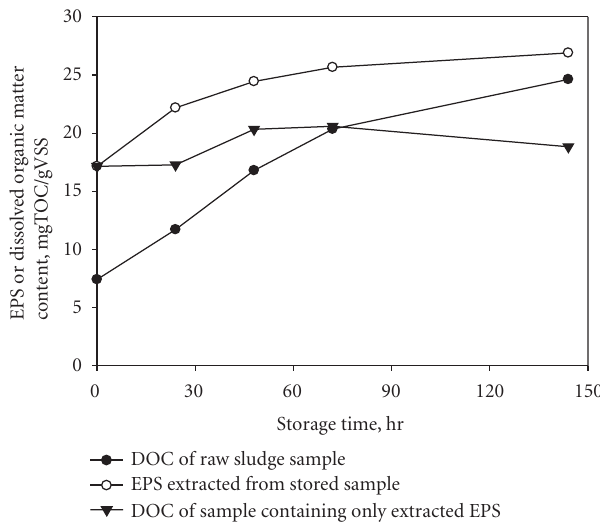
Figure 4: Storage e ff ect on the extraction process (Resin dose = 70g/gVSS; contact time = 1.5 hours; stirring intensity = 900 RPM). All the samples were stored at 4 ◦